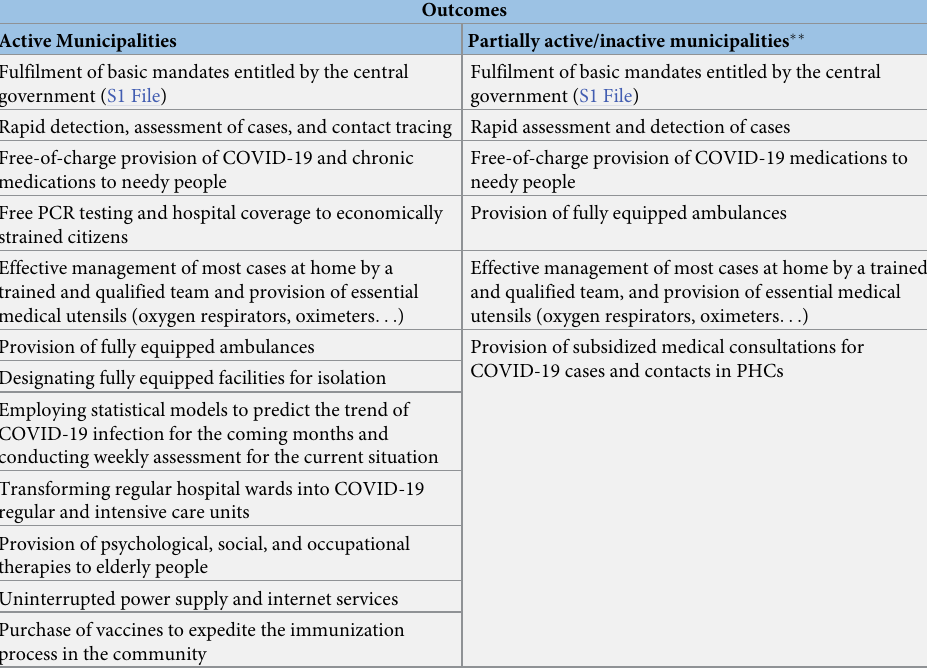
Table 1. Response of the active and partially active/inactive municipalities during COVID-19 pandemic.